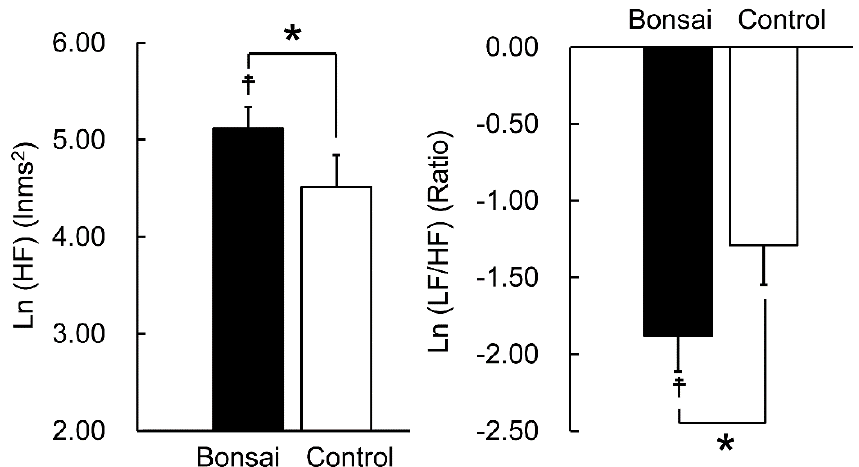
Figure 2. Heart rate variability during visual stimulation with bonsai vs control. Left: parasympathetic nervous activity, mean natural logarithm (ln) of the high ‐ frequency (HF) component; right: sympathetic nervous activity, mean natural logarithm (ln) of the ratio of low frequency (LF) to HF (LF/HF). Data are expressed as mean ± standard error ( n = 12). ‡ p < 0.05 (before vs after viewing), * p < 0.05 (bonsai vs control), according to a paired t ‐ test (one sided).